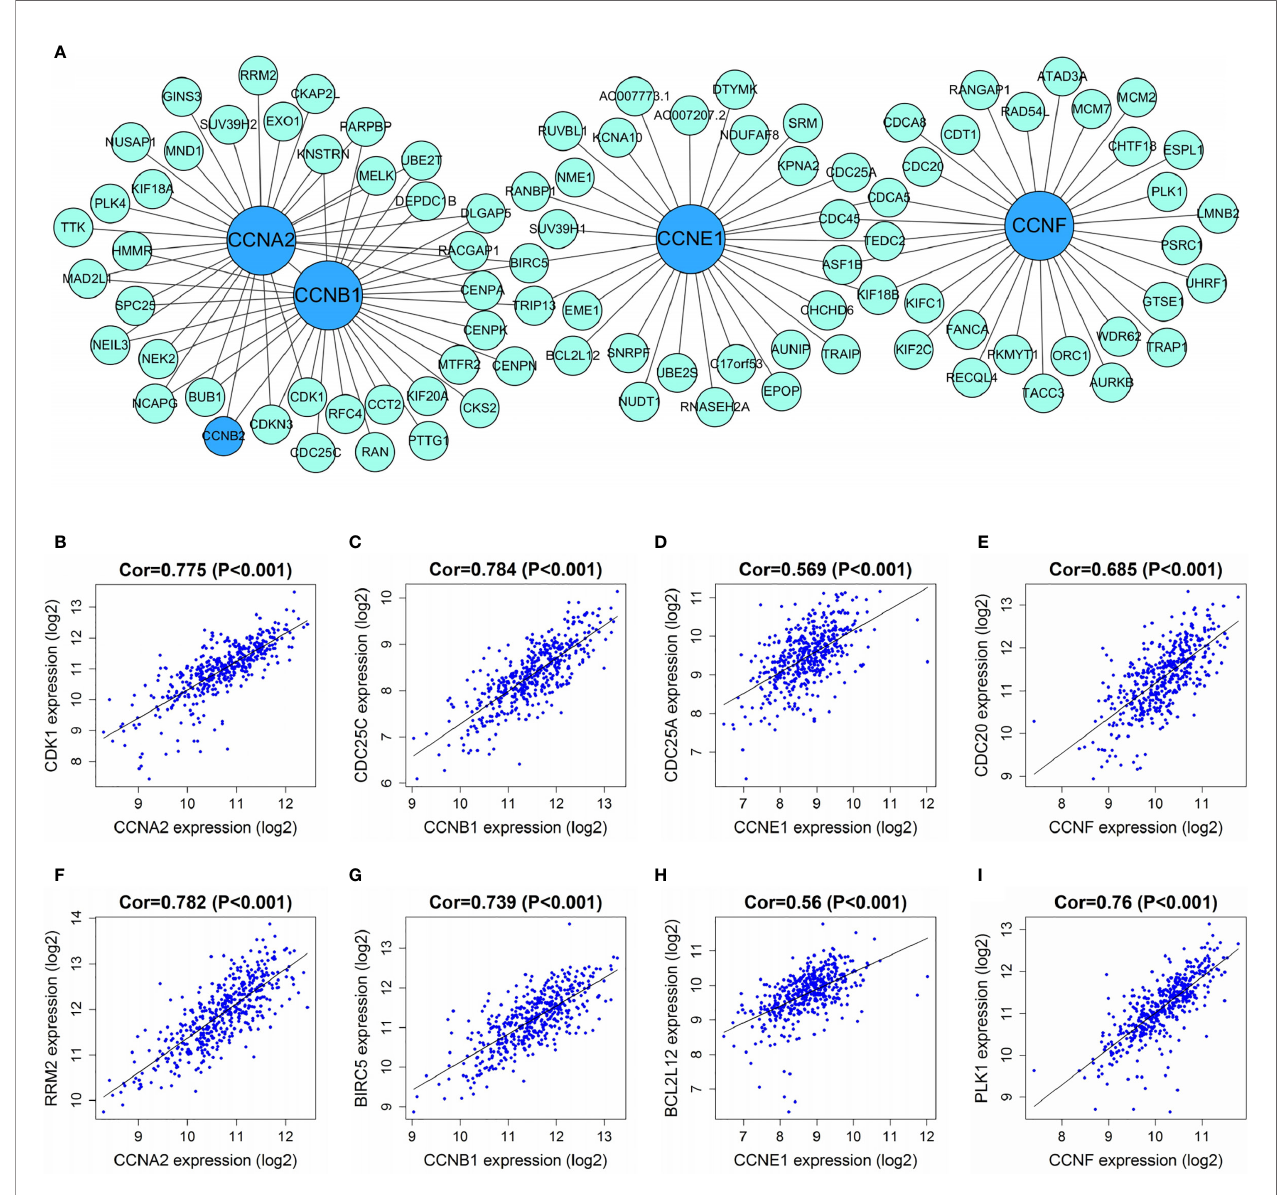
FIGURE 11 | Correlations between cyclin genes and other DEGs in TCGA dataset. (A) Co-expression network of the four signi fi cant cyclin genes and their co- expressed genes. The top 30 genes most correlated with each of them are presented. (B – E) The four cyclin genes were tightly linked to cell cycle-relevant genes ( CDK1 , CDC25C , CDC25A , and CDC20 ). (F – I) The four cyclin genes had close connections with the mTOR- ( RRM2 ) and cancer-related genes ( BIRC5 , BCL2L12 , and PLK1 ). Cor, correlation coef fi